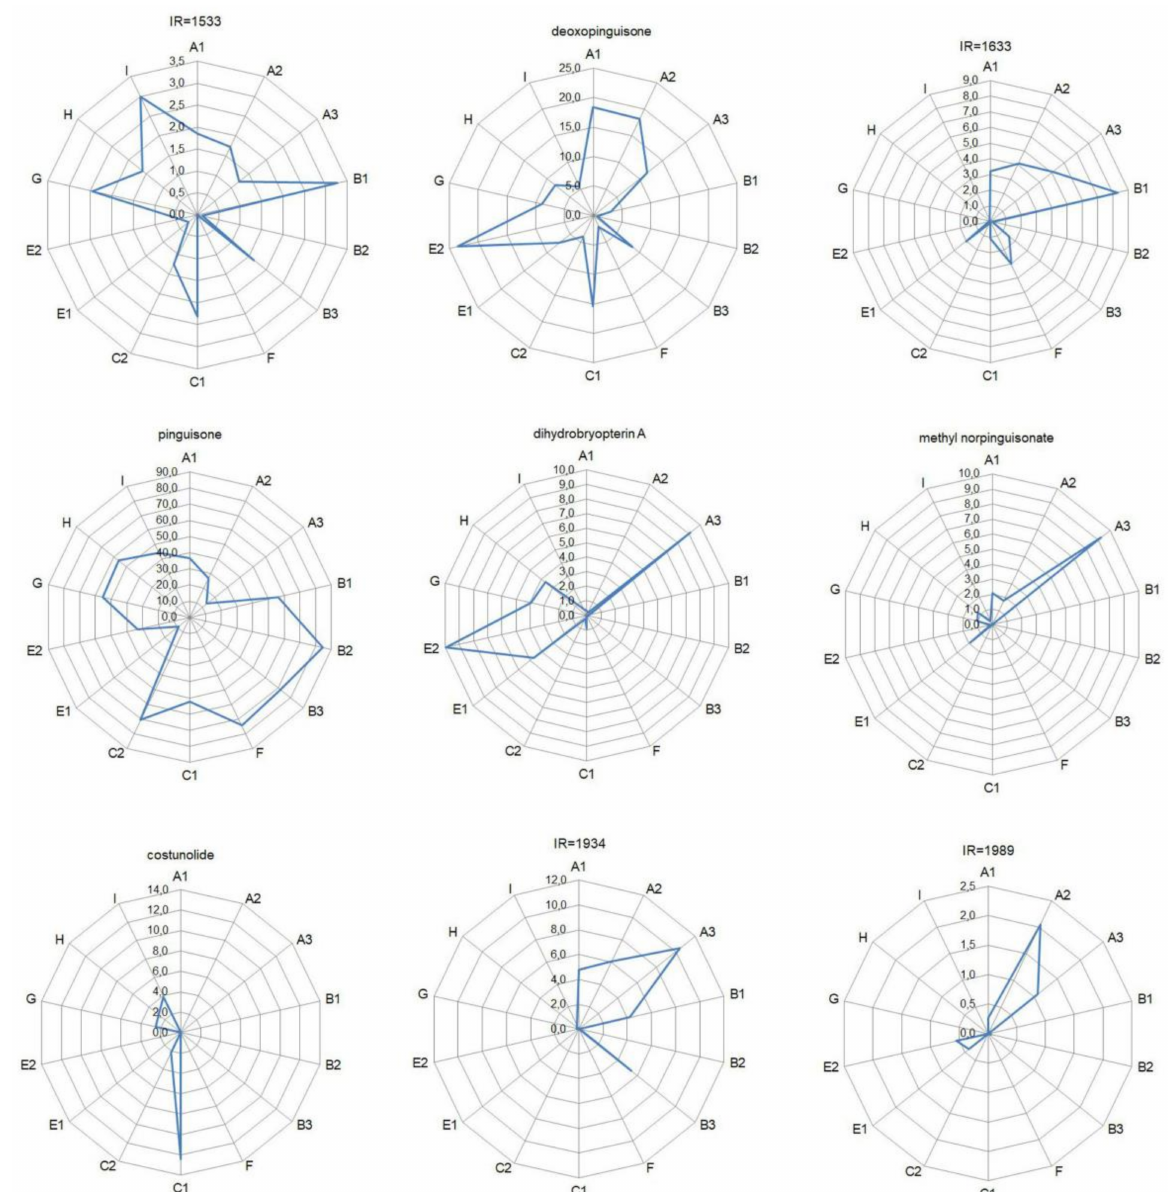
Figure 3. Radar chart for marker compounds used to identify genetic lineages. The contents of compounds for individual genetic lineages are given in